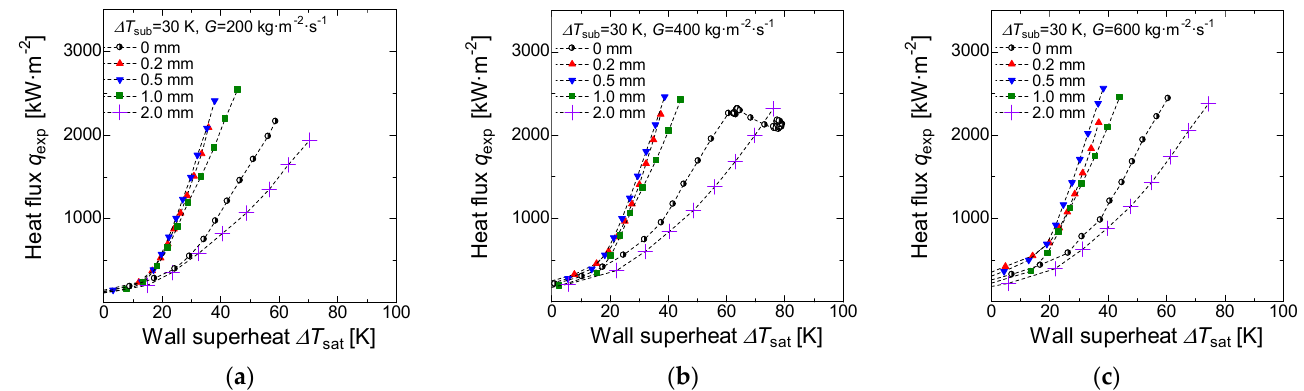
Figure 4. Maximum heat flux for all the porous thickness, inlet subcooling temperature ∆ T sub = 30 K: ( a ) G = 200 kg · m − 2 · s − 1 , ( b ) G = 400 kg·m − 2 s − 1 , ( c ) G = 600 kg·m − 2 s − 1 .